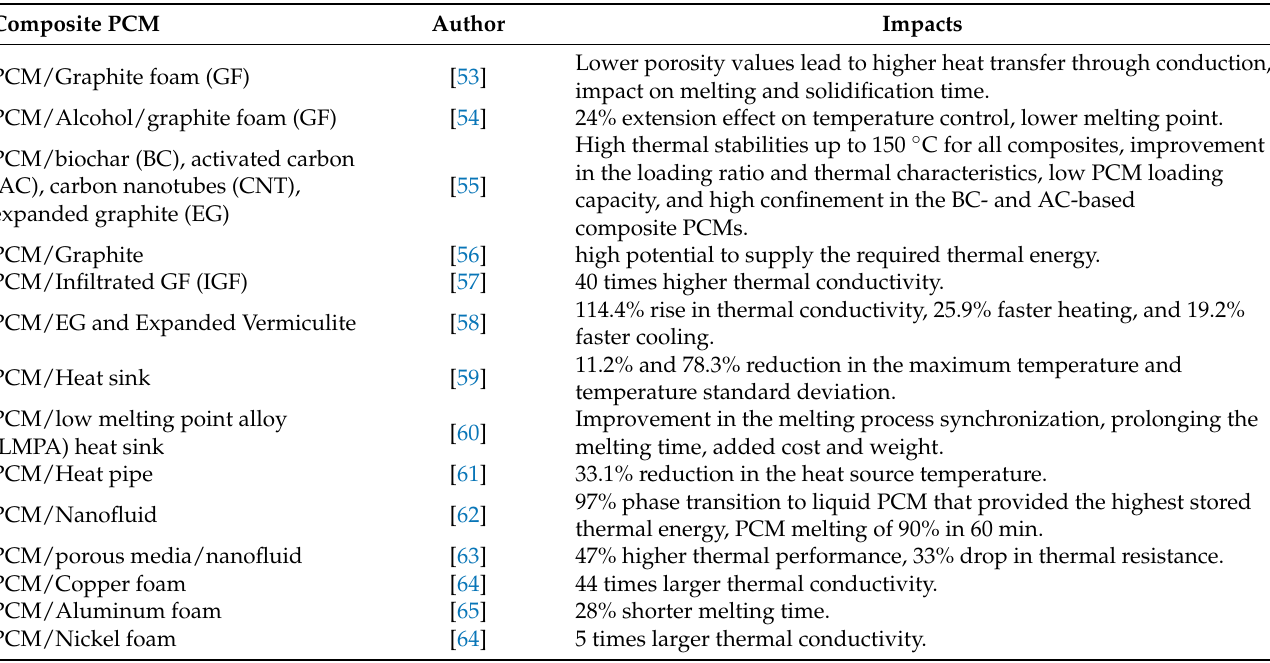
Table 1. Summary of the composite PCMs in the literature.